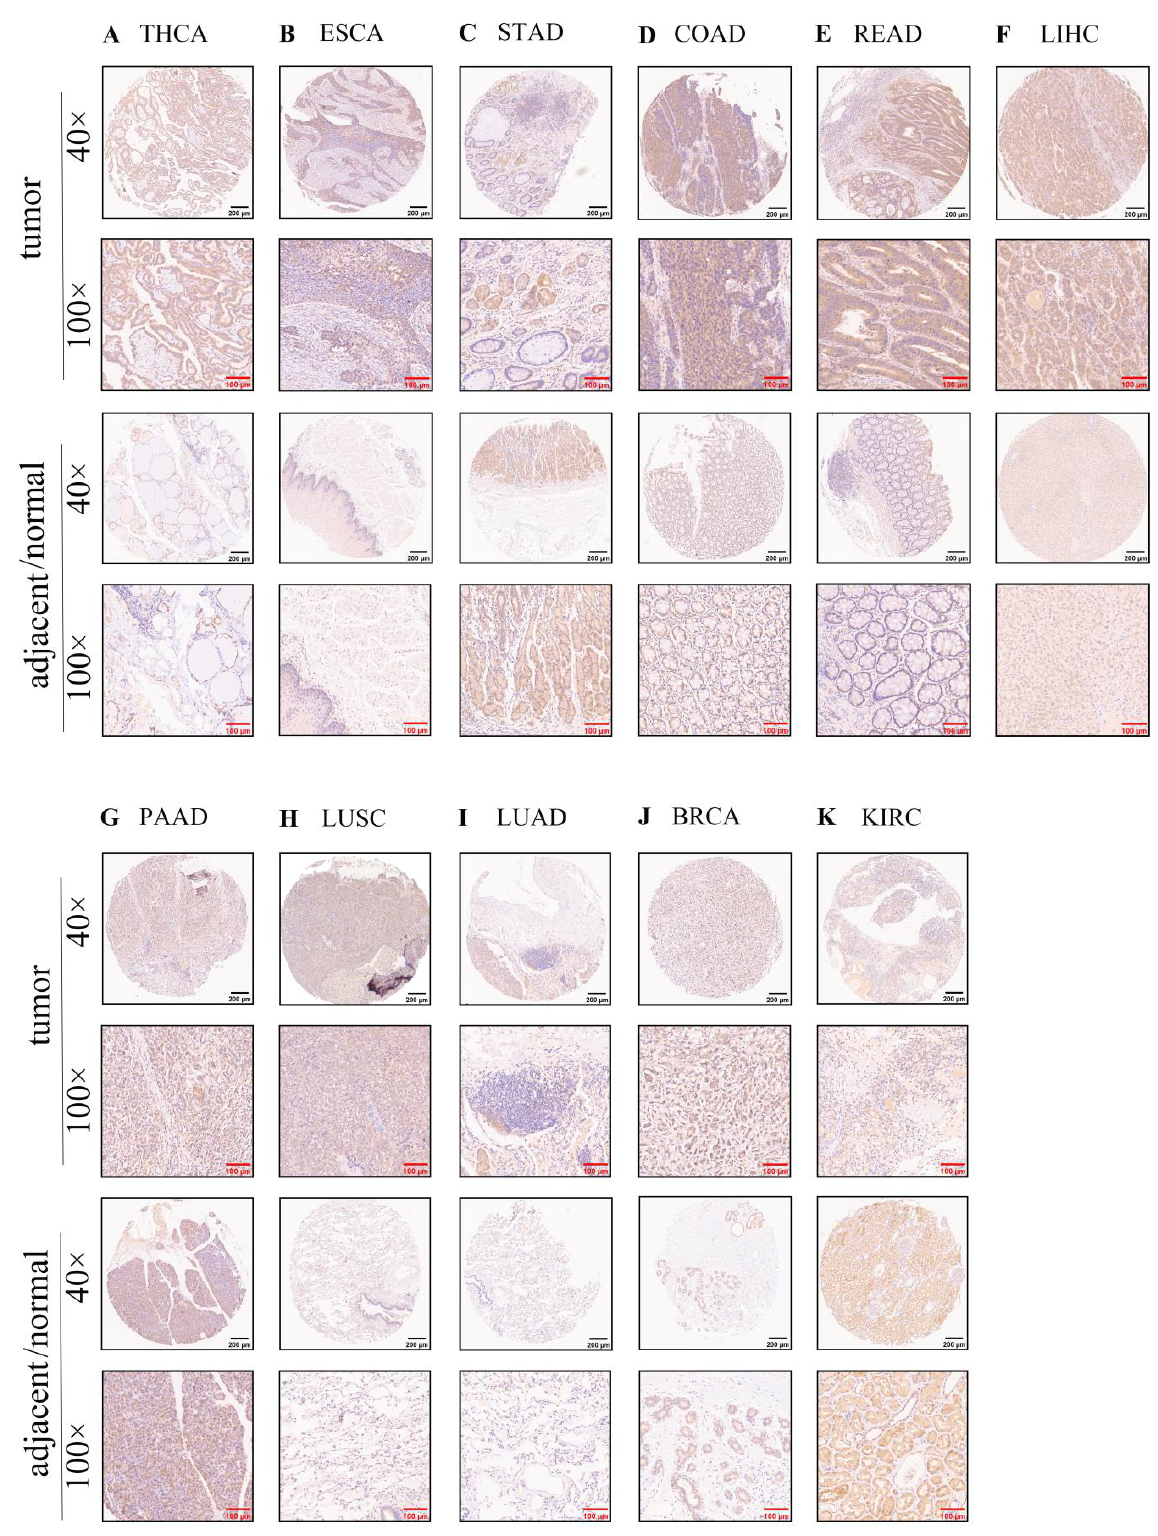
GTEX normal tissues. The red color column represents the cancer samples, and the blue color col- umn represents the normal samples. ns, p ≥ 0.05; **, p < 0.01; and ***, p < 0.001.